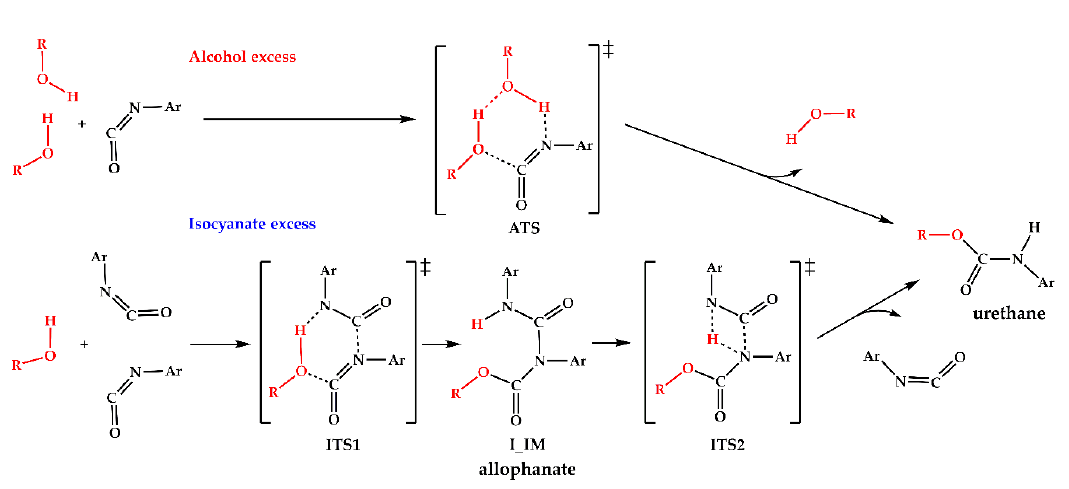
Figure 1. Elementary reaction mechanism for urethane bond formation. The alcohol excess mechanism (top) involves a hydrogen-bonded alcohol associate as the reactant, while the isocyanate excess mechanism (bottom) starts with dipole-dipole stabilized intermolecular isocyanate dimer. In the present study R = Pr and Ar = Ph.